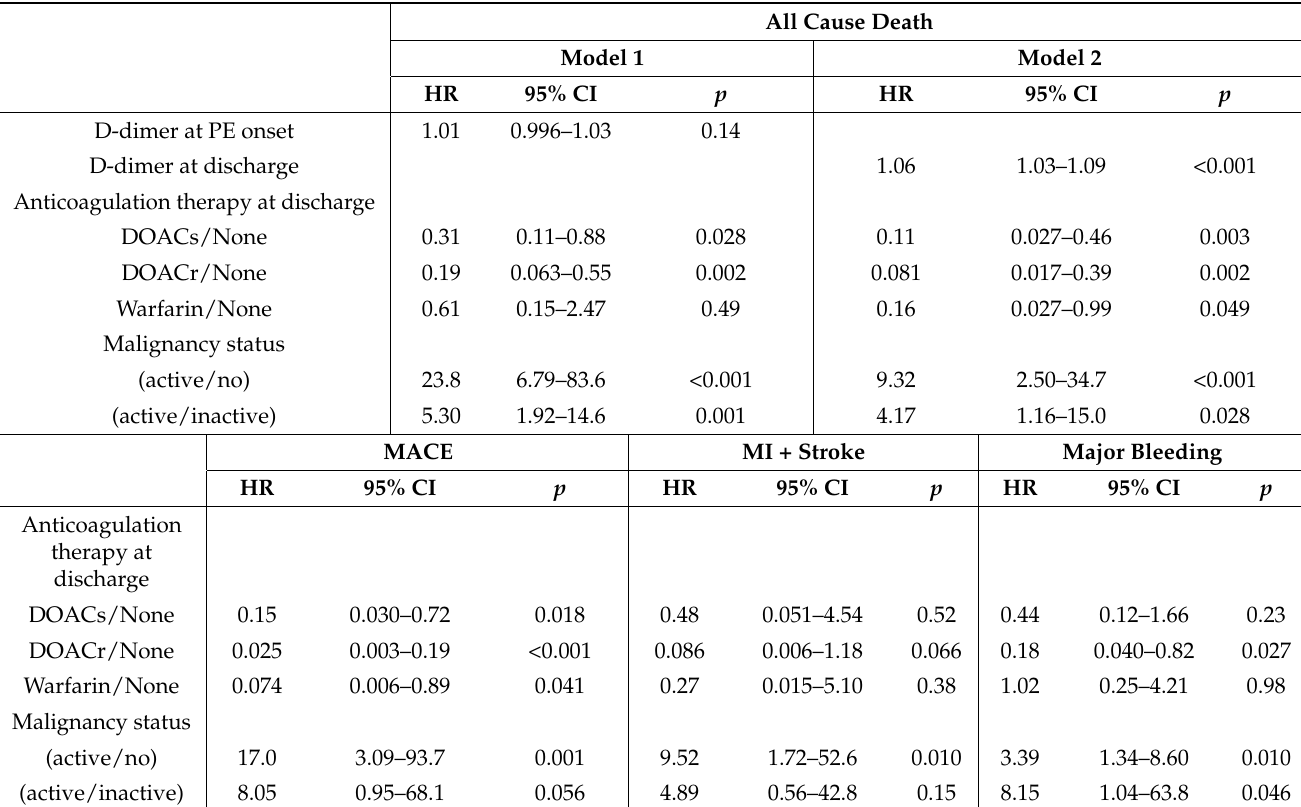
Table 4. Multivariable Cox proportional hazard model analysis for clinical endpoints.